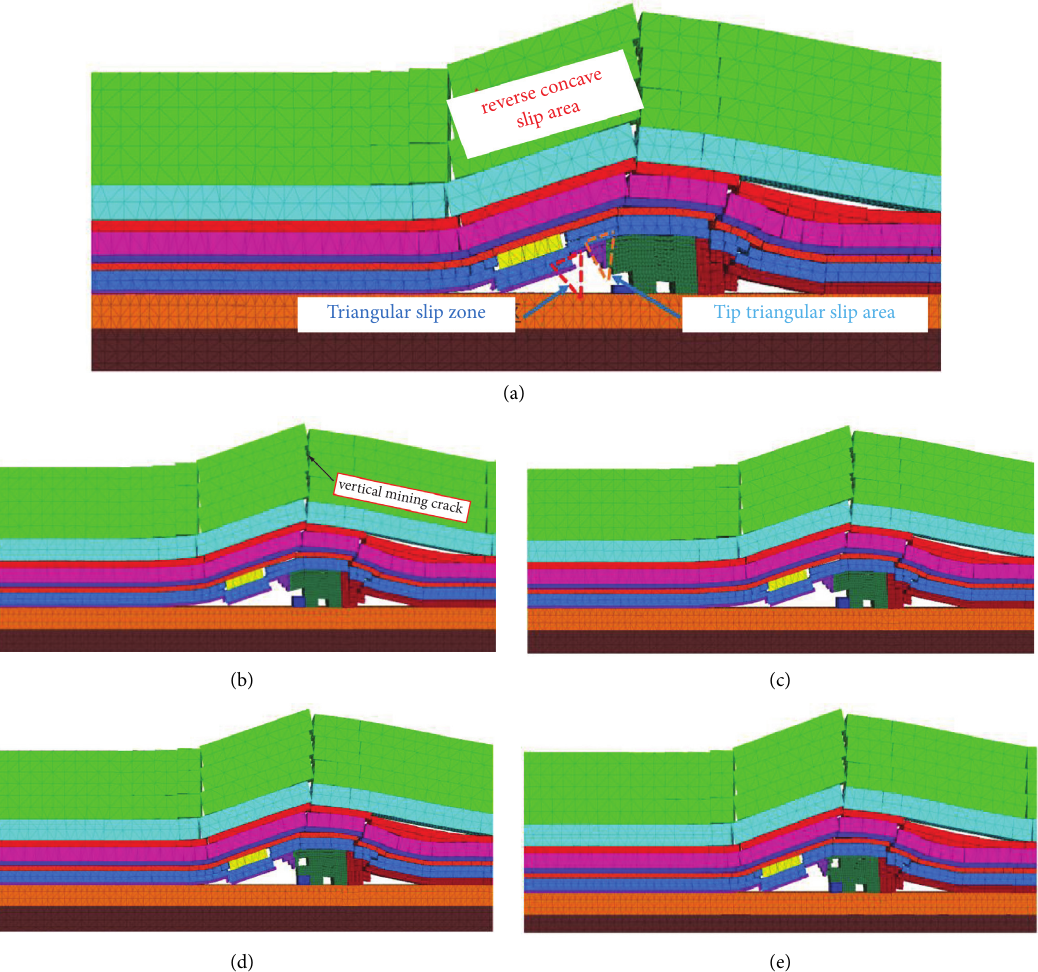
Figure 10: Overlying rock movement caused by recovery at the 30503 working face and its impact on new roadway 2 (new roadway 1 remains unfilled). (a) H � − 2m. (b) H � 0m. (c) H � 2m. (d) H � 4m. (e) H � 6m.